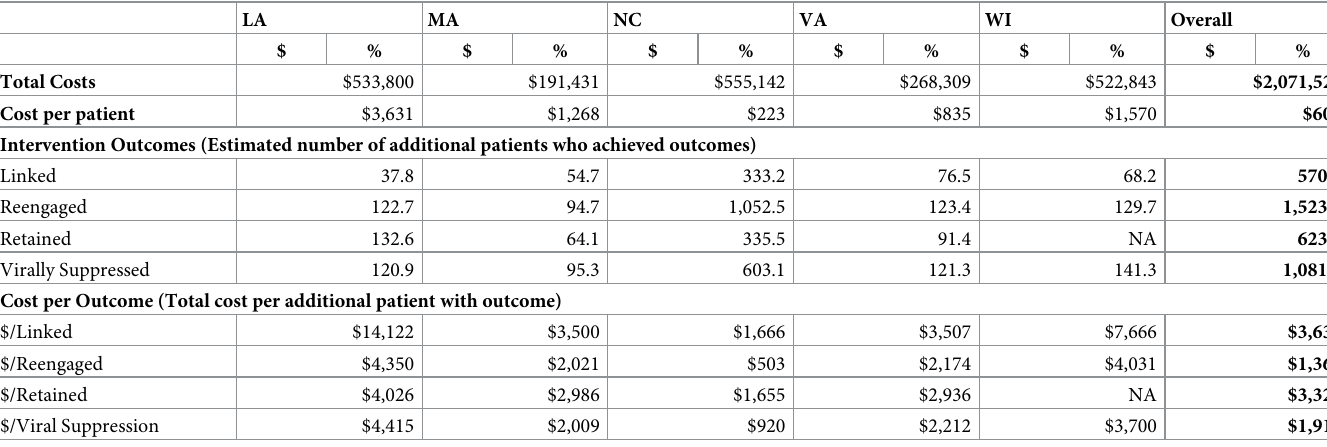
Table 4. Cost per outcome of patient navigation